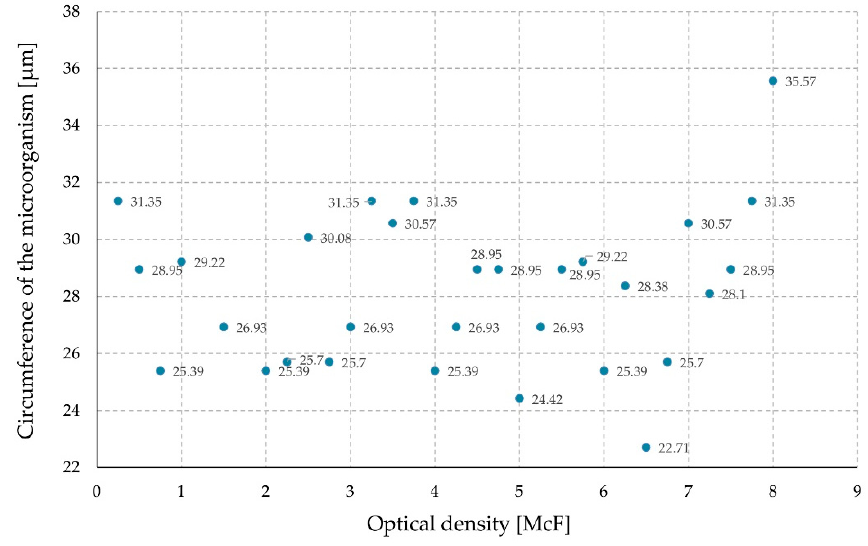
Figure 7. Circumference of the microorganism in relation to the optical density of the suspension. The surface area of the microorganism was also determined (Figure 8). As in the above-mentioned cases, the influence of the surface of the microorganism on the optical density and the measurement result was excluded in the case of sensor